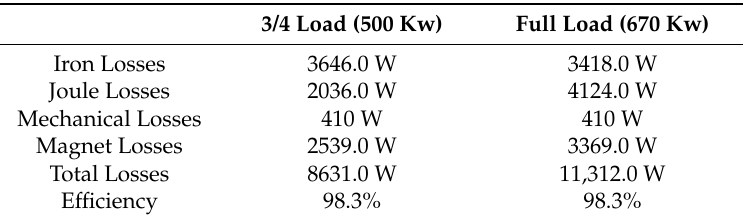
Table 14. Losses and